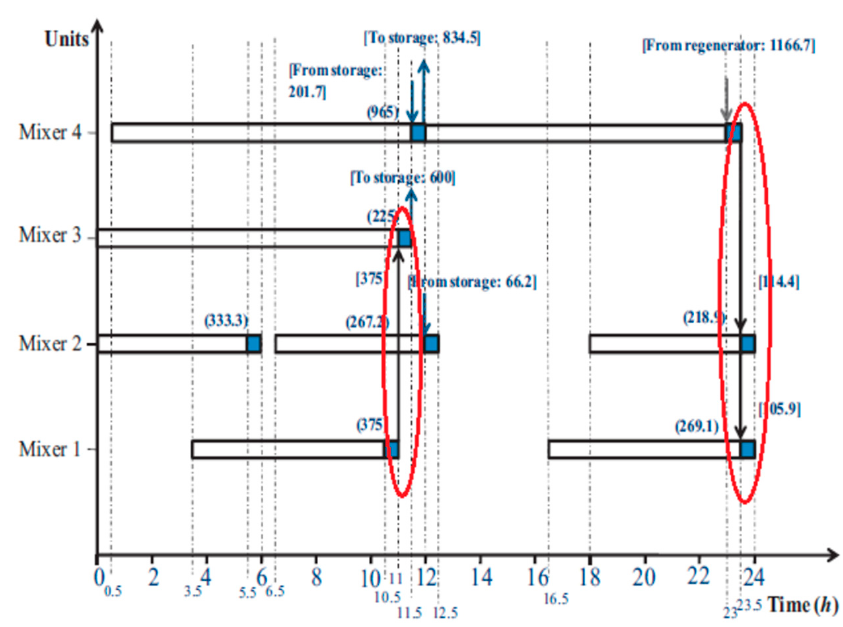
Figure 16. Reported Gantt chart for case study 4 from Adekola and Majozi [11] with contaminant mass balance violation shown in red colored oval.